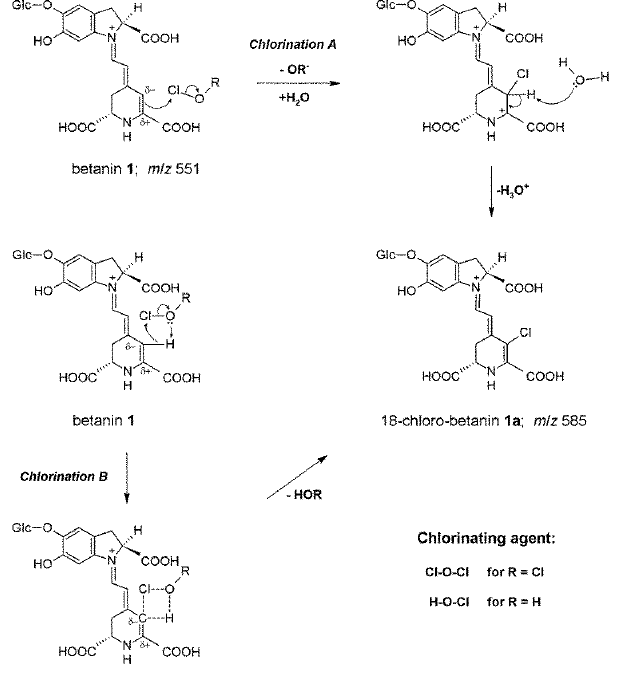
Figure 1. Proposed mechanism of betanin chlorination based on two versions, A and B [5,18], of the Cl + ion attack on the carbon C-18. In version B, a cyclic intermediate [18] formed during electrophilic